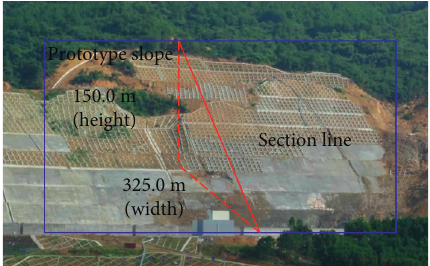
Figure 1: Overlook of the prototype